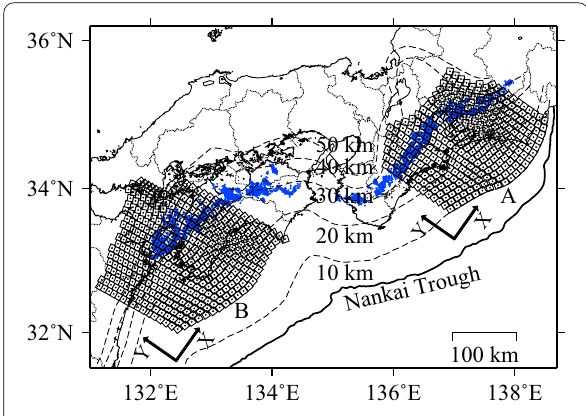
Fig. 2 Set of subfaults (rectangles) and grid points (black dots) used for the inversion analyses. Each grid point is at the center of a rectangle defining a small subfault on the plate interface. The dashed contours indicate the depth of the subducting Philippine Sea plate interface north of the Nankai Trough. Blue dots indicate the hypocenters of deep low-frequency tremors during 2015–2018